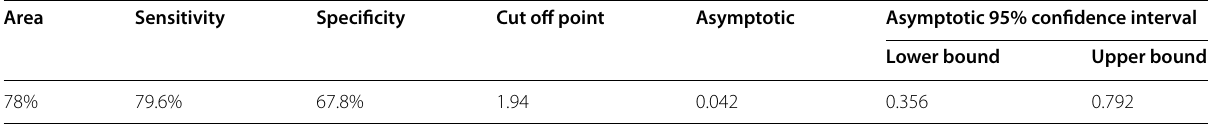
Table 5 Roc curve of N/L ratio in the case